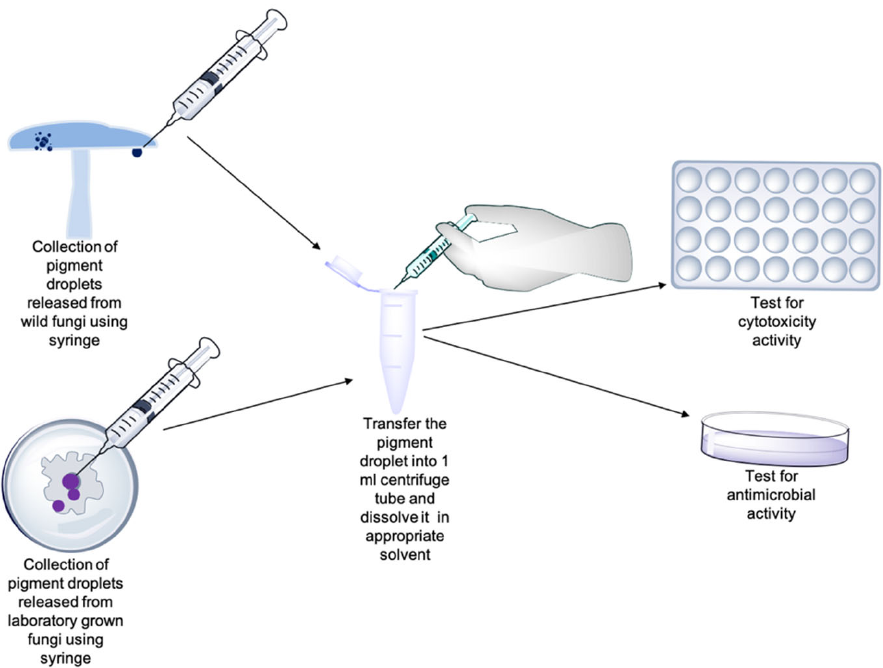
Figure 3. Isolation of concentrated pigment droplets (authors’ unpublished data) released by fungi on their mycelia surfaces and testing them directly for biological properties in a simple and rapid way. Before or after confirming the bioactivity, these pigment droplets can be purified with TLC as shown in Figure